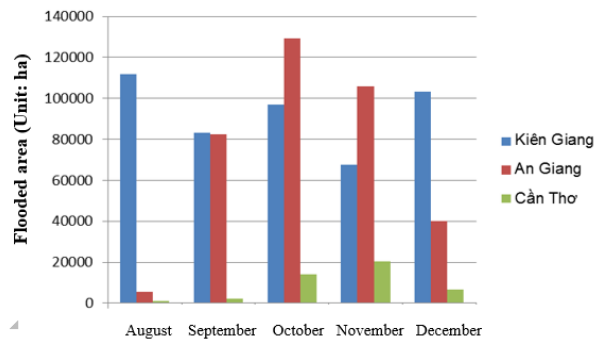
Figure 4: The fluctuation of flooded area in three provinces belong to